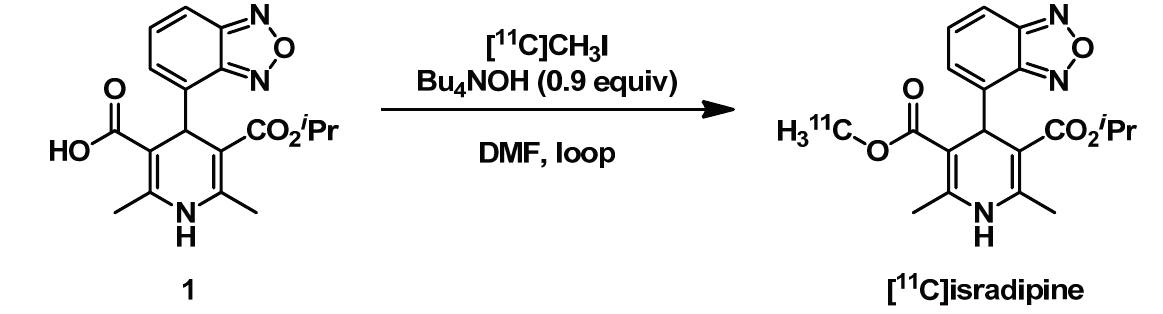
Figure 3. Radiosynthesis of [ 11